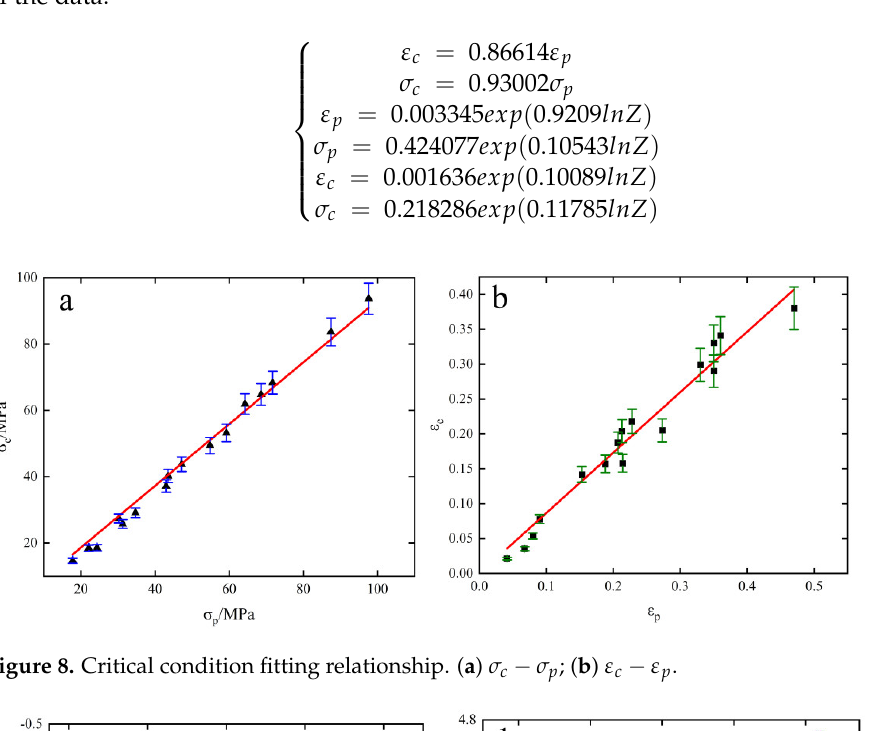
c − σ p ; ( b ) ε c − ε p .